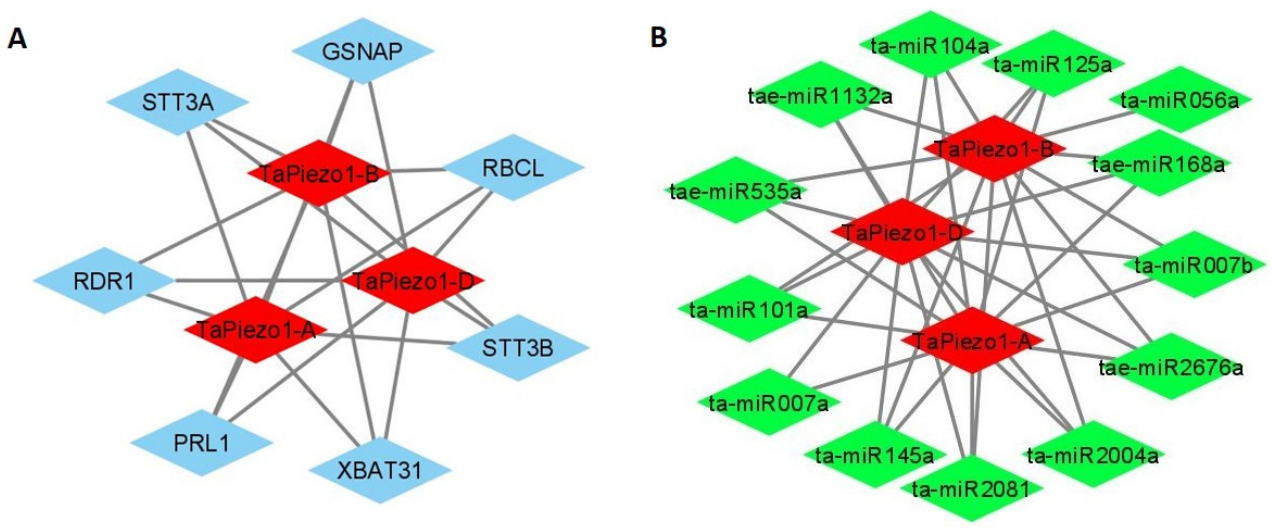
Figure 7. Protein–protein and miRNA interaction analysis of Piezo of T. aestivum . The network ( A ) shows the protein–protein interactions, where TaPiezo proteins are represented with red and predicted interacting proteins with blue. The interaction network ( B ) of predicted miRNA with TaPiezo genes. The interaction networks were built using the Cytoscape